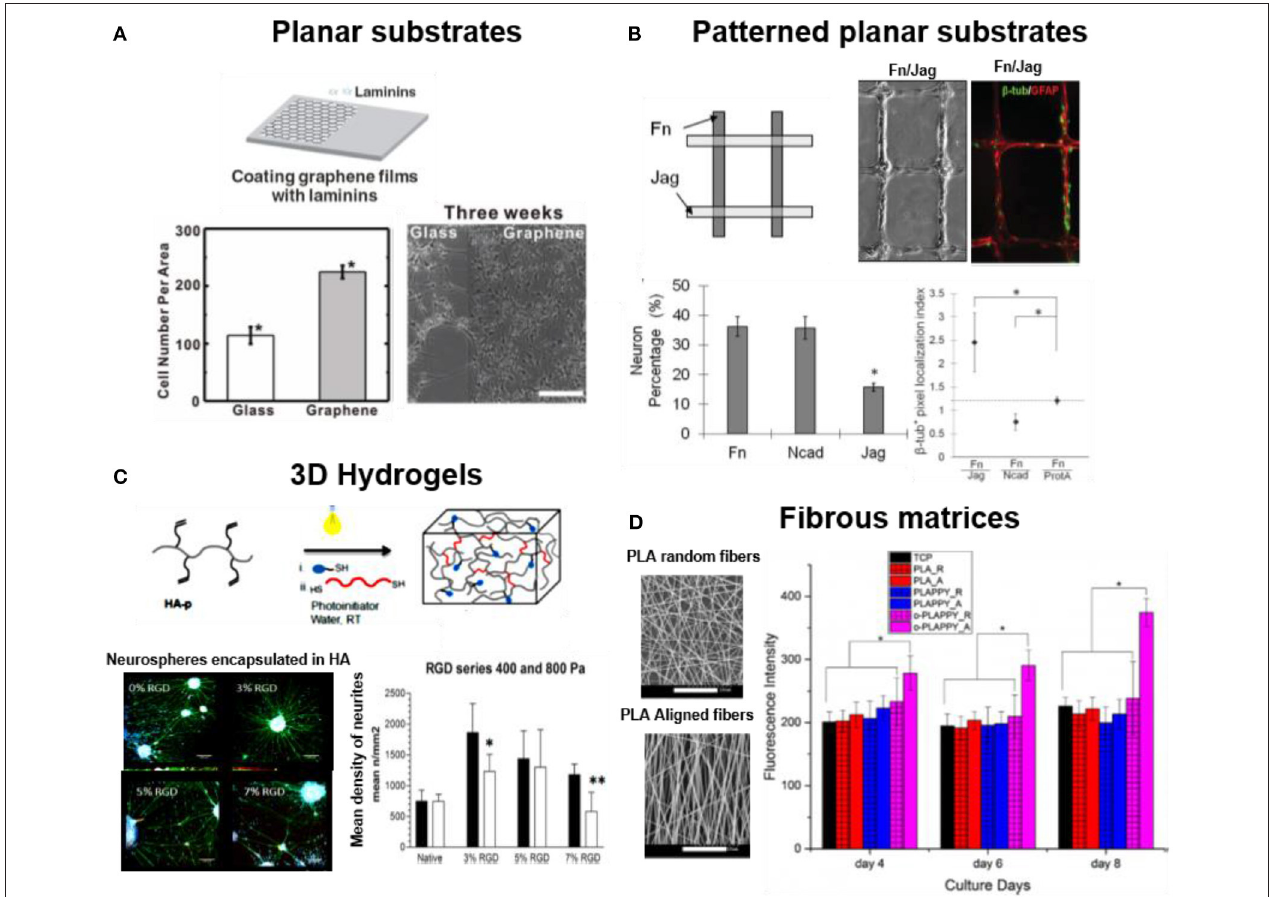
FIGURE 2 | Dimensionality in neuronal cell cultures. Examples of 2D and 3D substrates supporting attachment of neuronal cells (A) hNSCs cultured on laminin coated glass and on graphene film (Park et al., 2011) Copyright 2011, John Wiley and Sons; (B) NSCs cultured on micro-contact printed patterns of FN, Jag or N-cadherin adhesive proteins on PDMS films. FN support higher neuronal cell adhesion while combination of FN/Jag support neuronal differentiation ( Wang et al., 2014) Copyright 2014, John Wiley and Sons; (C) Neural cultures in 3D gels of soft (Young’s Modulus = 0.4 kPa) photopolymerized hyaluronic acid functionalized with RGD. The soft hydrogel facilitated neurite extension from encapsulated neurospheres during 17 days of culture ( Tarus et al., 2016) Copyright 2016, American Chemical Society; (D) Neural cultures on 3D fibrous matrices of aligned (-A) and random PLA fibers (-R), modified with polypyrrole (PLAPPY) and poly-ornithine (o-PLAPPY) ( Tian et al., 2016) Copyright 2016,